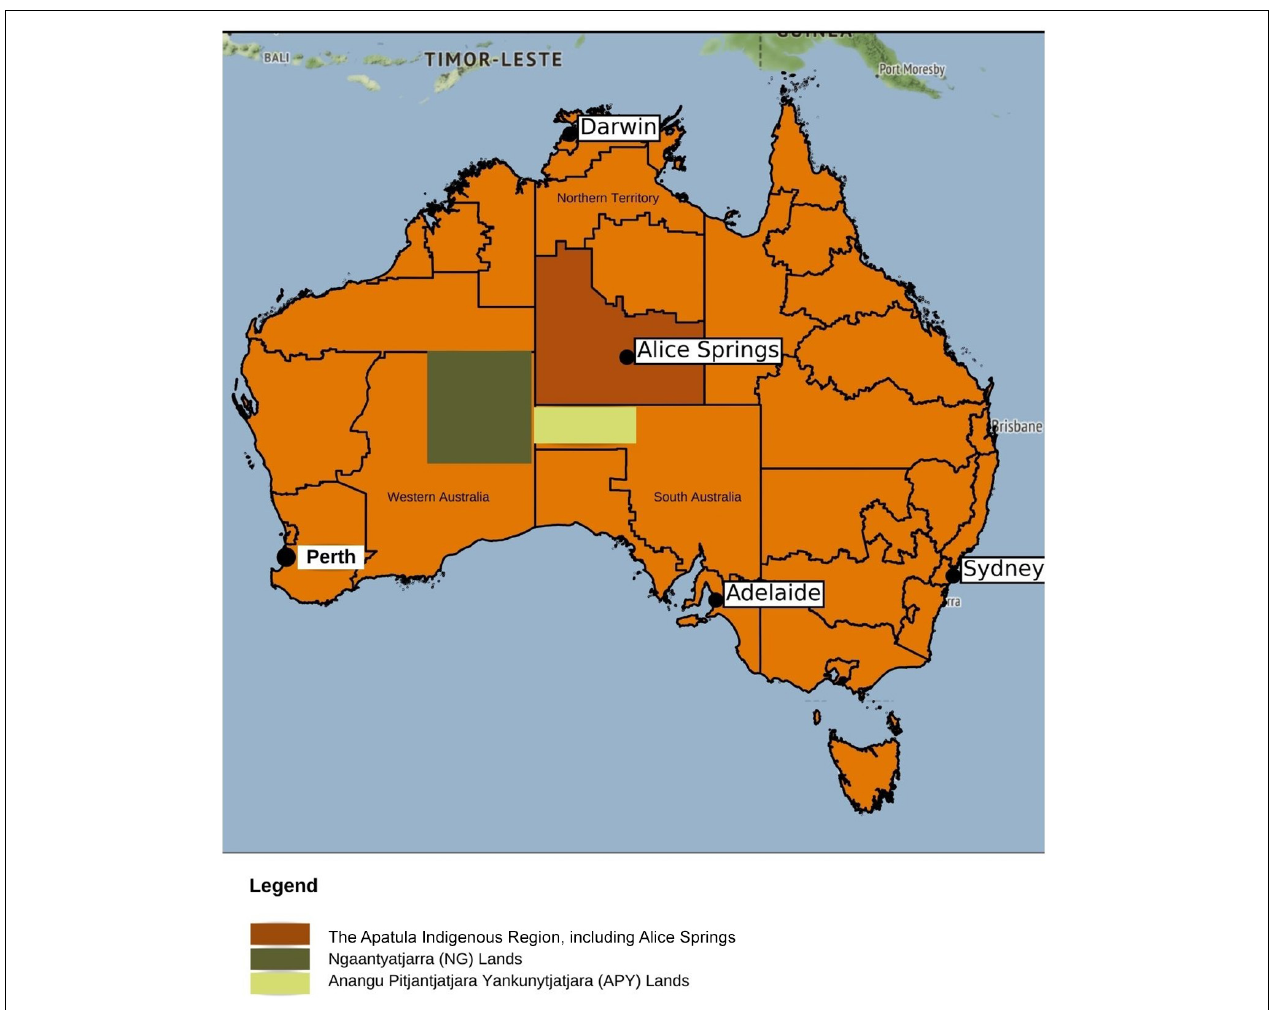
FIGURE 1 | Map of Central Australia. Central Australia covers a remote tri-state region of more than 500 million square kilometres. It includes the vast geographies and diverse language groups of the Ngaanyatjarra (NG) lands, the Anangu Pitjantjatjara Yankunytjatjara (APY) lands and the southern pans of the Northern Territory, including the health hub and regional centre of Alice Springs. These are shown by the shaded sections in above map. *Map not to scale. Modified figure © OpenStreetMap